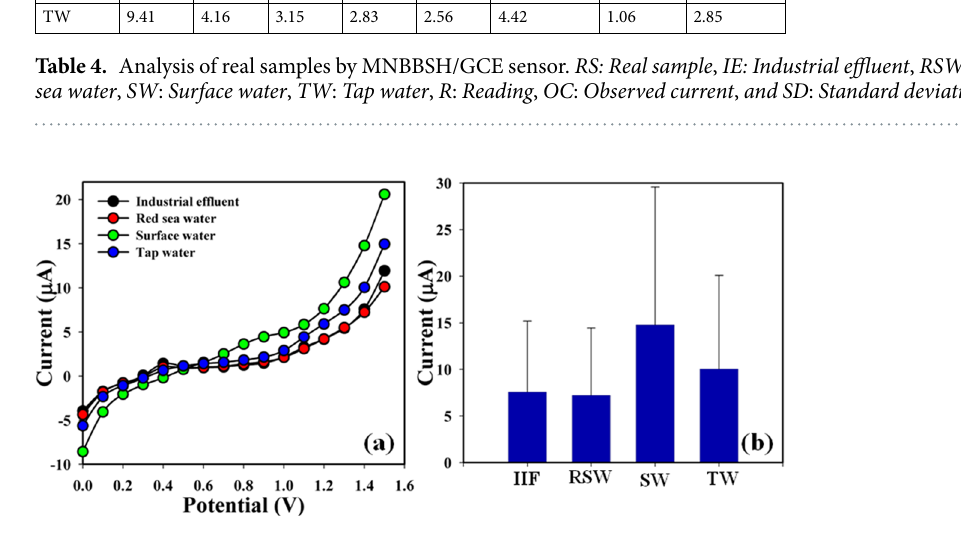
Figure 11. ( a ) Real samples analysis and ( b ) Bar diagram presentation of RS at + 1.4 V.